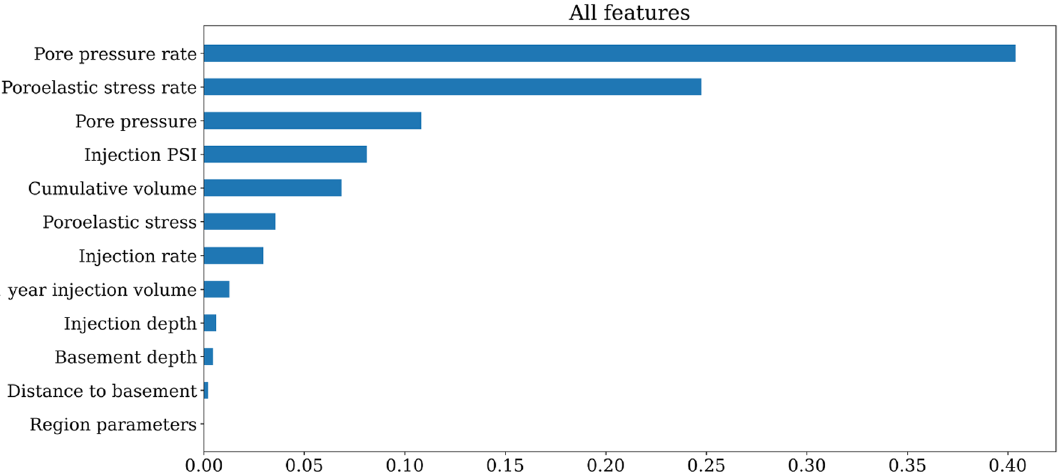
Figure 4. Histogram of feature importance from the RF model. The most important features are pore pressure rate, poroelastic stress rate, and pore